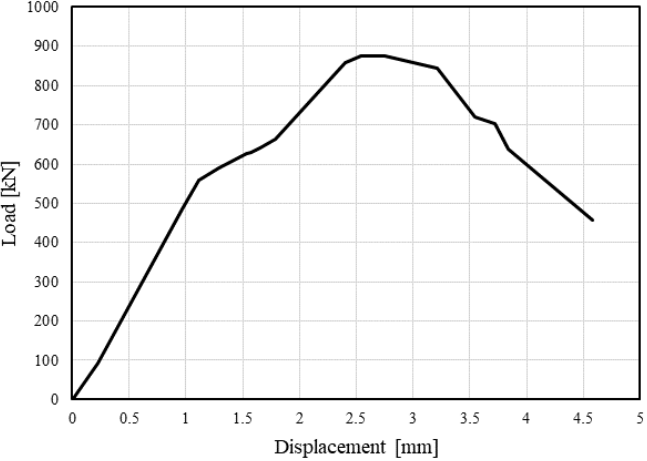
Figure 3. Experimental load vs. displacement curve.